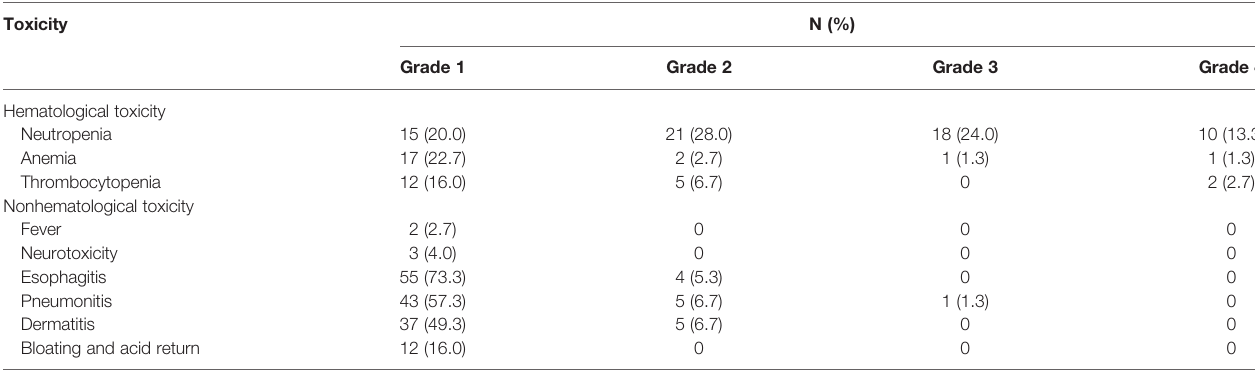
TABLE 3 | Acute Treatment Toxicity.